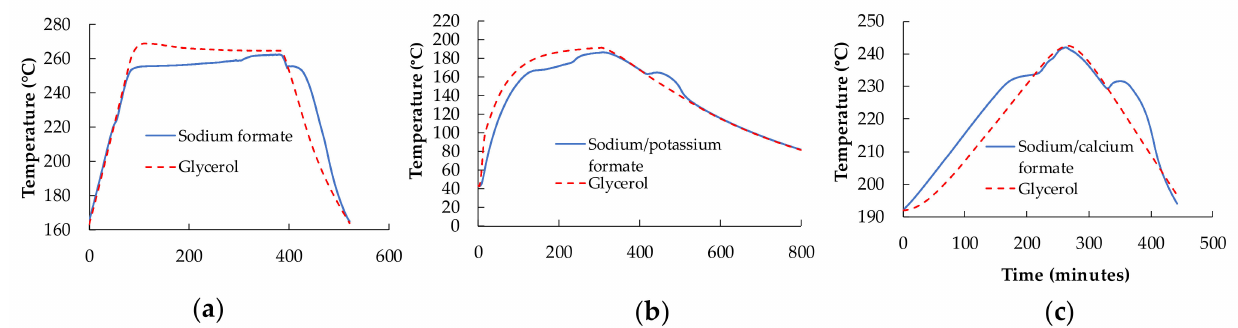
Figure 3. T-history experimental results of PCM vs. glycerol reference: ( a ) sodium formate, ( b ) sodium/potassium formate, and ( c ) sodium/calcium formate. The temperature difference between the onset of the hump in the cool-down curve and the maximum rise in the hump represents the degrees of supercooling